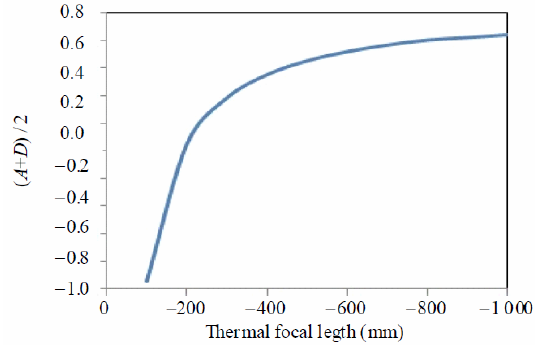
Fig. 5 Resonator stability verses thermal focal length in Nd: YLF